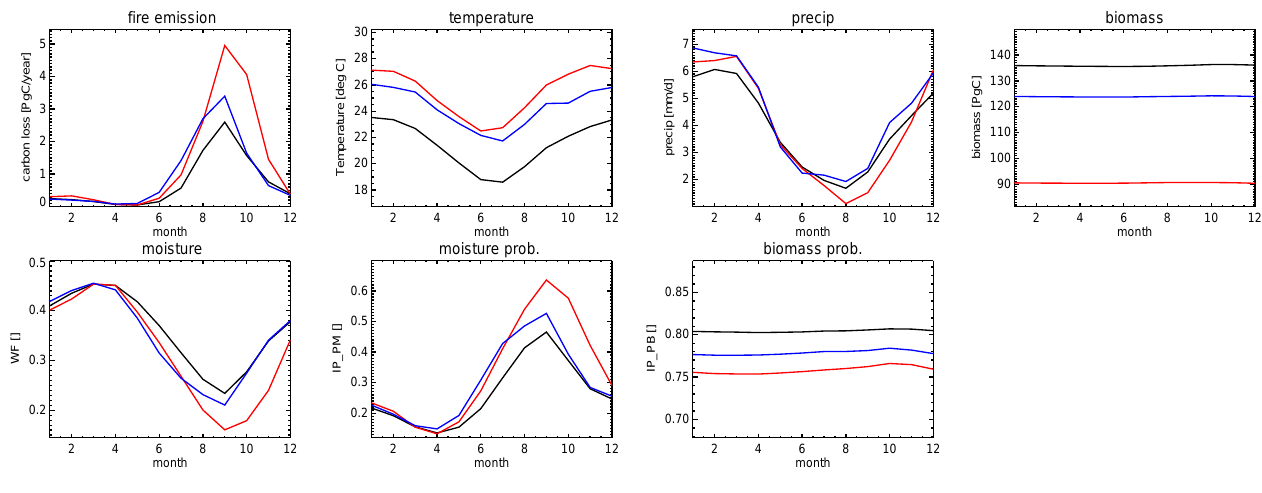
Fig. 11. Similar as Fig. 10 for the region Southern Hemisphere South America